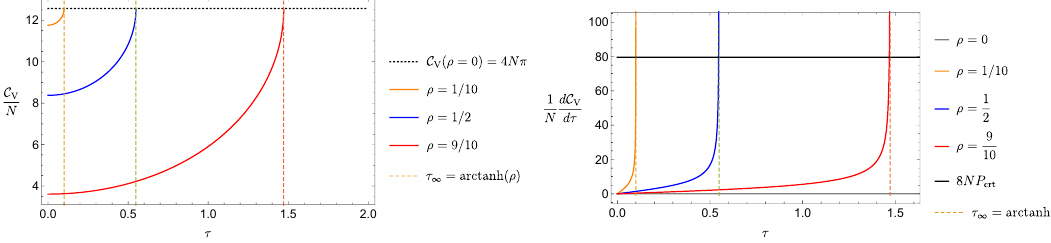
in dS 2 . Right:Time evolution of V